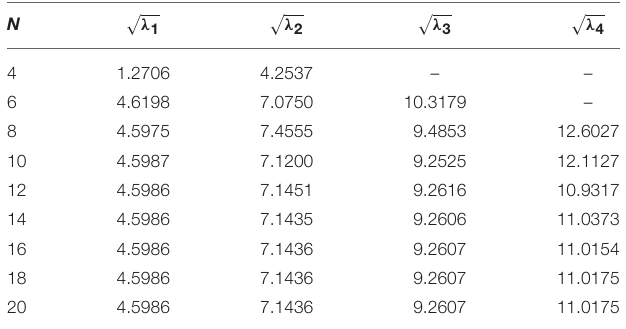
TABLE 9 | Convergence for CC case.